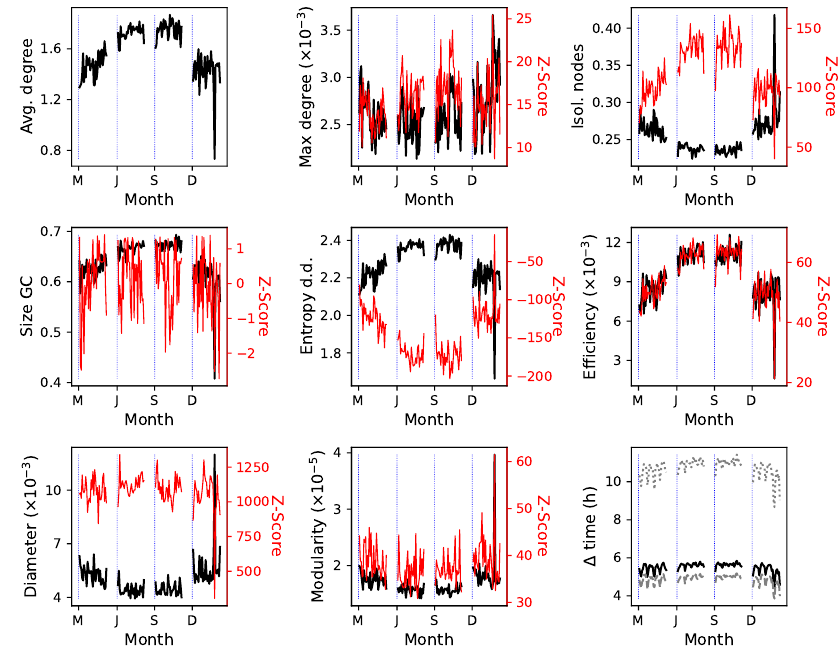
Figure A8. Properties of the interaction networks for planned trajectories in 2018. Each panel depicts the evolution through time of a topological metric, as defined in Section 2; black (left Y axes) and red lines (right Y axes), respectively, correspond to the raw values and their Z-Scores. The vertical blue dotted lines represent the beginning of each month. In the last panel, the black line corresponds to the median, the gray dashed one to the mean, and the gray dotted one to the maximum. M: March; J: June; S: September; and D: